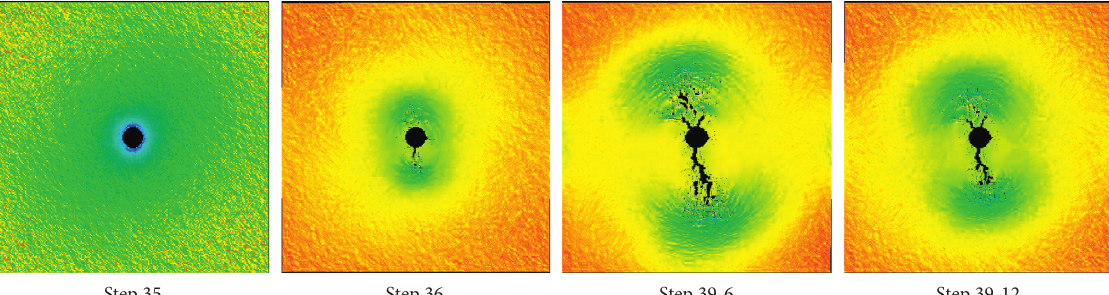
Figure 3: Hydraulic fracture evolution of single-wellbore model ( m � 2, K � 1).